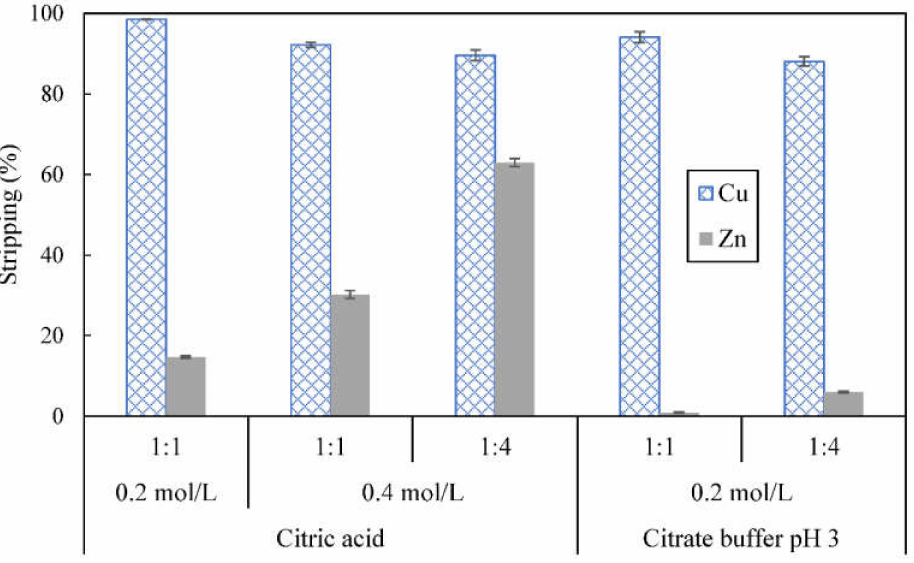
Figure 10. Effect of O:A ratio and citrate buffer on stripping of metal ions from loaded organic phase; concentration of D2EHPA used was 4% ( v / v ), stripping time = 5